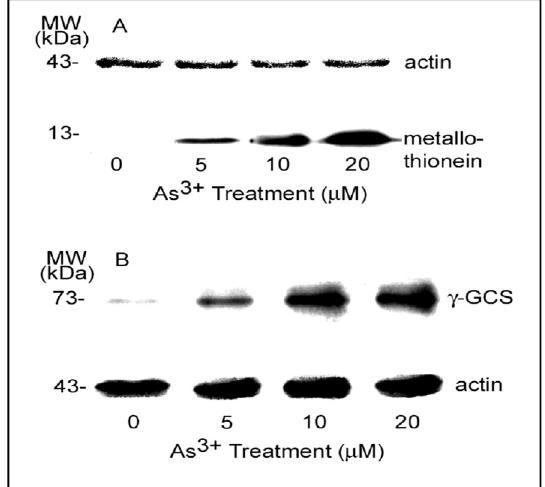
Figure 8. As 3+ enhanced expression of metallothionein and  -GCS. Growth-arrested RFL6 cells were treated with As 3+ at indicated concentrations for 24 h and processed for Western blot analysis. ( A ) metallothionein (I and II); ( B )  - GCS heavy chain; actin as an internal